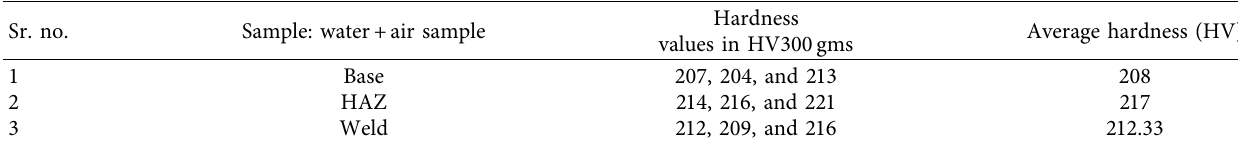
Table 4: Microhardness values in sample 4 (tempered in water+air). Sr. no.